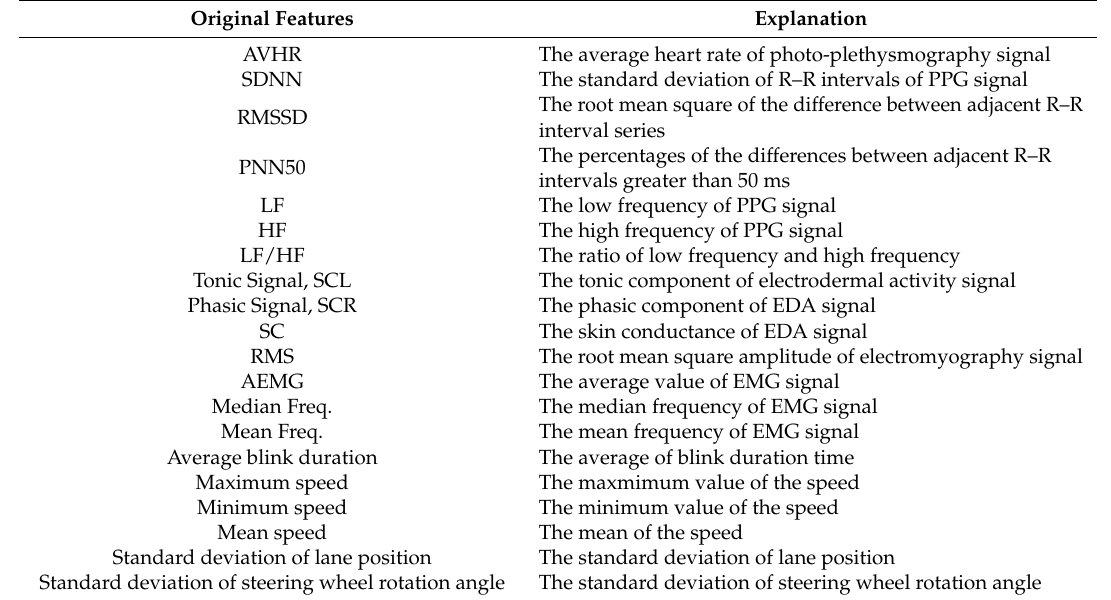
Table 1. Description of the